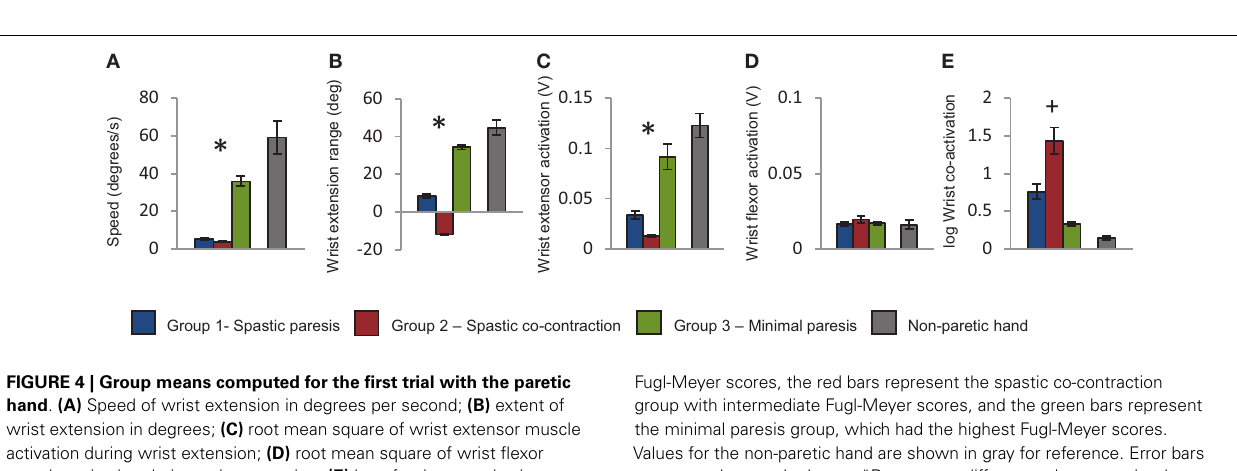
FIGURE 4 | Group means computed for the first trial with the paretic hand . (A) Speed of wrist extension in degrees per second; (B) extent of wrist extension in degrees; (C) root mean square of wrist extensor muscle activation during wrist extension; (D) root mean square of wrist flexor muscle activation during wrist extension; (E) log of wrist co-activation computed as ratio of wrist flexor to extensor muscle activation.The blue bars represent the group with spastic paresis, which had the lowest